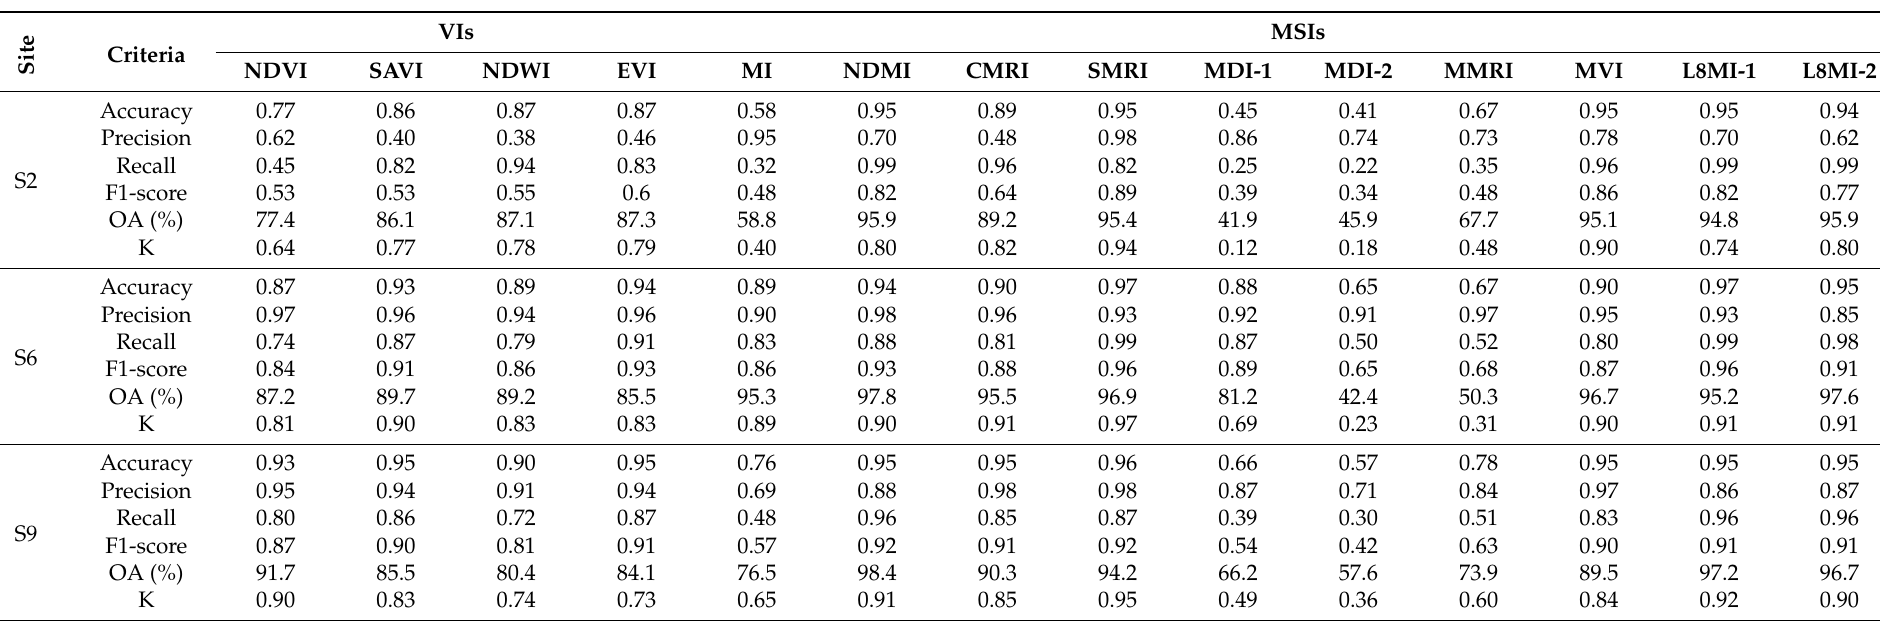
Table 2. The accuracy assessment of mangrove forest mapping on the images of VIs and MSIs determined from Landsat 8 data classified by SVM algorithm in